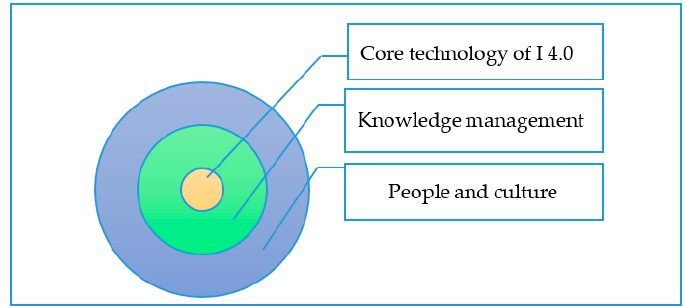
Figure 5. General fields on the way to Industry 4.0. Source: own study.